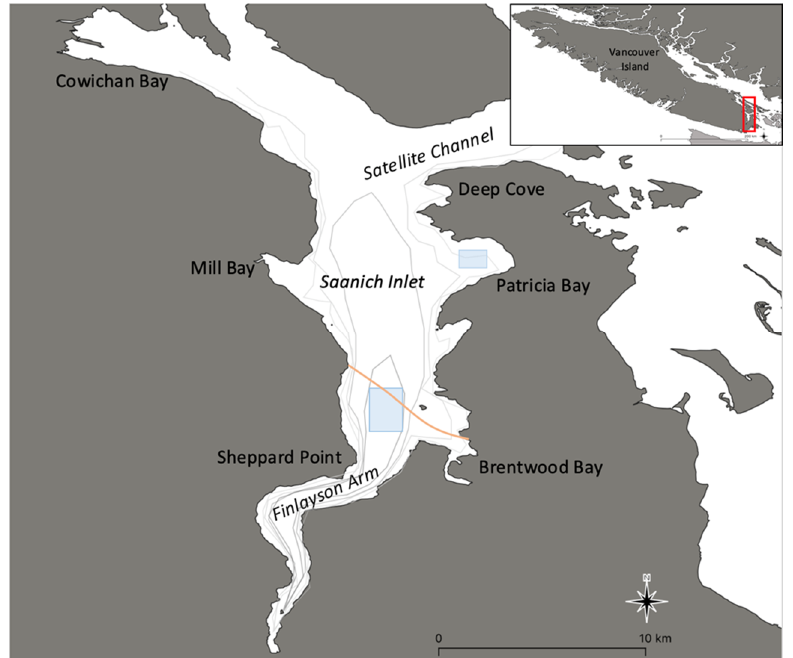
Figure 1. Study area on Vancouver Island outlined in red on the inset map. The areas used for shallow-water transects completed in Patricia Bay, and the deep-water transects in Saanich Inlet, approximately between Sheppard Point and Senanus Island are shown (blue shaded areas). The Mill Bay–Brentwood Bay ferry route is marked in orange.